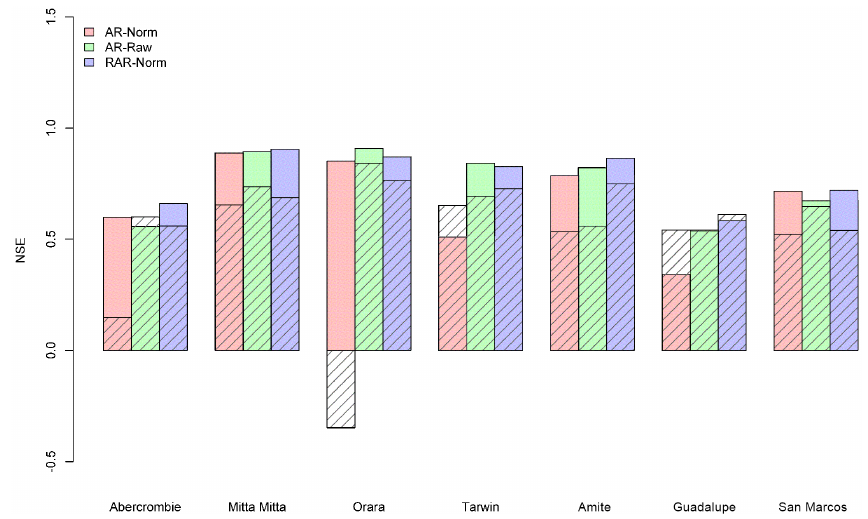
Figure 7. NSE of streamflows forecast with the AR-Norm, AR-Raw and RAR-Norm models (colours). Performance of the corresponding base hydrological models is shown by hatched